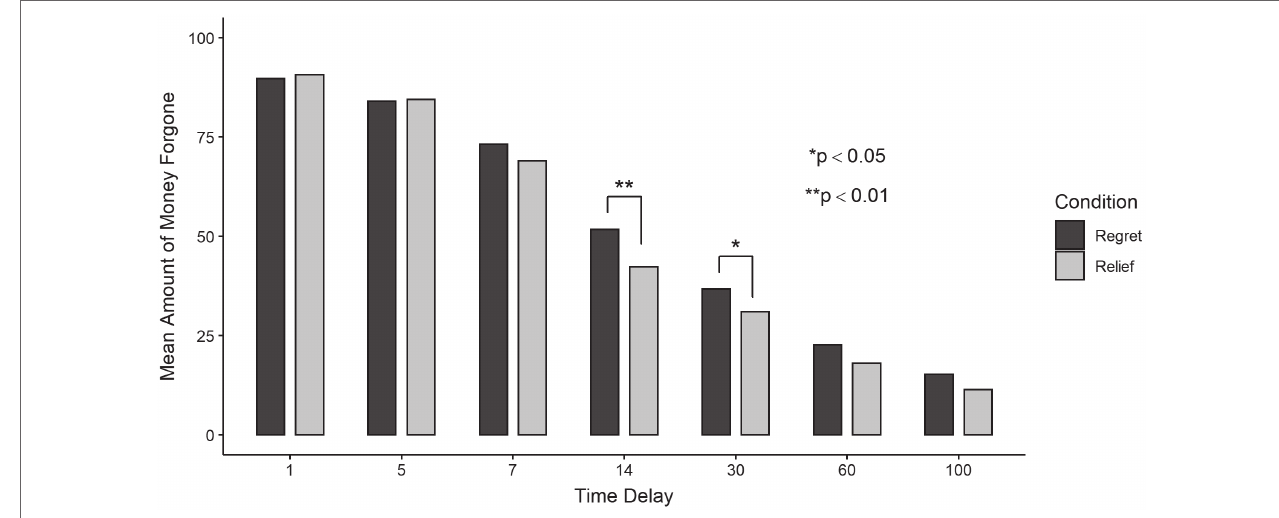
FIGURE 4 | Mean amount of money forgone per delay in the RF and RT